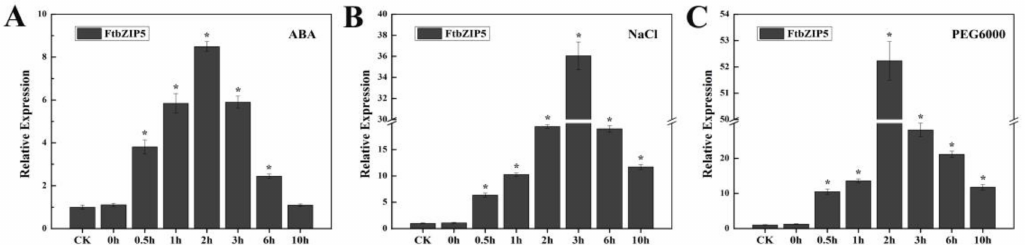
Figure 2. Expression patterns of FtbZIP5 following ABA ( A ), NaCl ( B ) and PEG6000 ( C ) treatments. The transcriptional abundance of FtbZIP5 in the absence of a stress treatment was used as the CK (control check). Error bars represent ± SD, and each value represents the averages of three repetitions. Significant di ff erence values were replaced by * to indicate p <